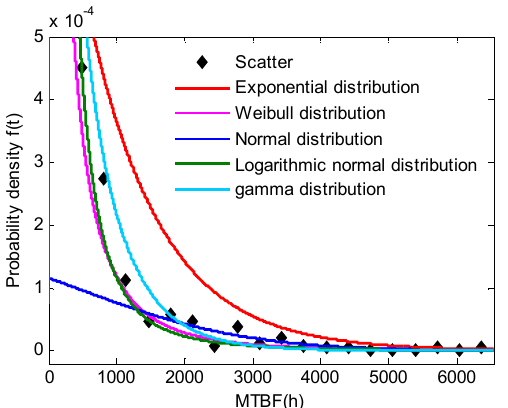
Figure4. Probability density curve of time between failures of total machine. MTBF—mean time between failures.